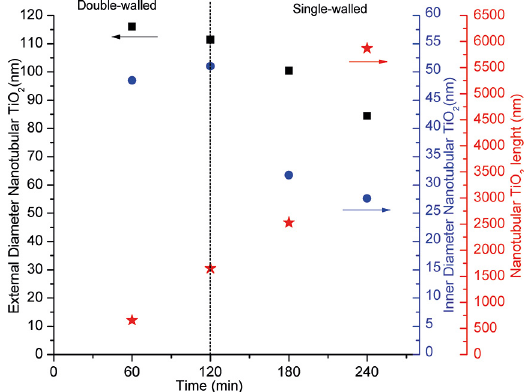
Figure 4. Diagram of nanotube inner diameter (a), external diameter (b) and length (c).